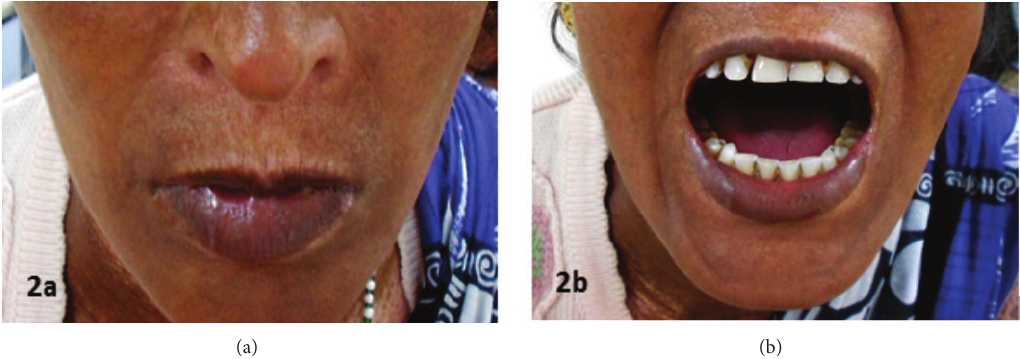
Figure 2: (a, b) Reduced oral aperture and resultant microstomia with limited oral access.